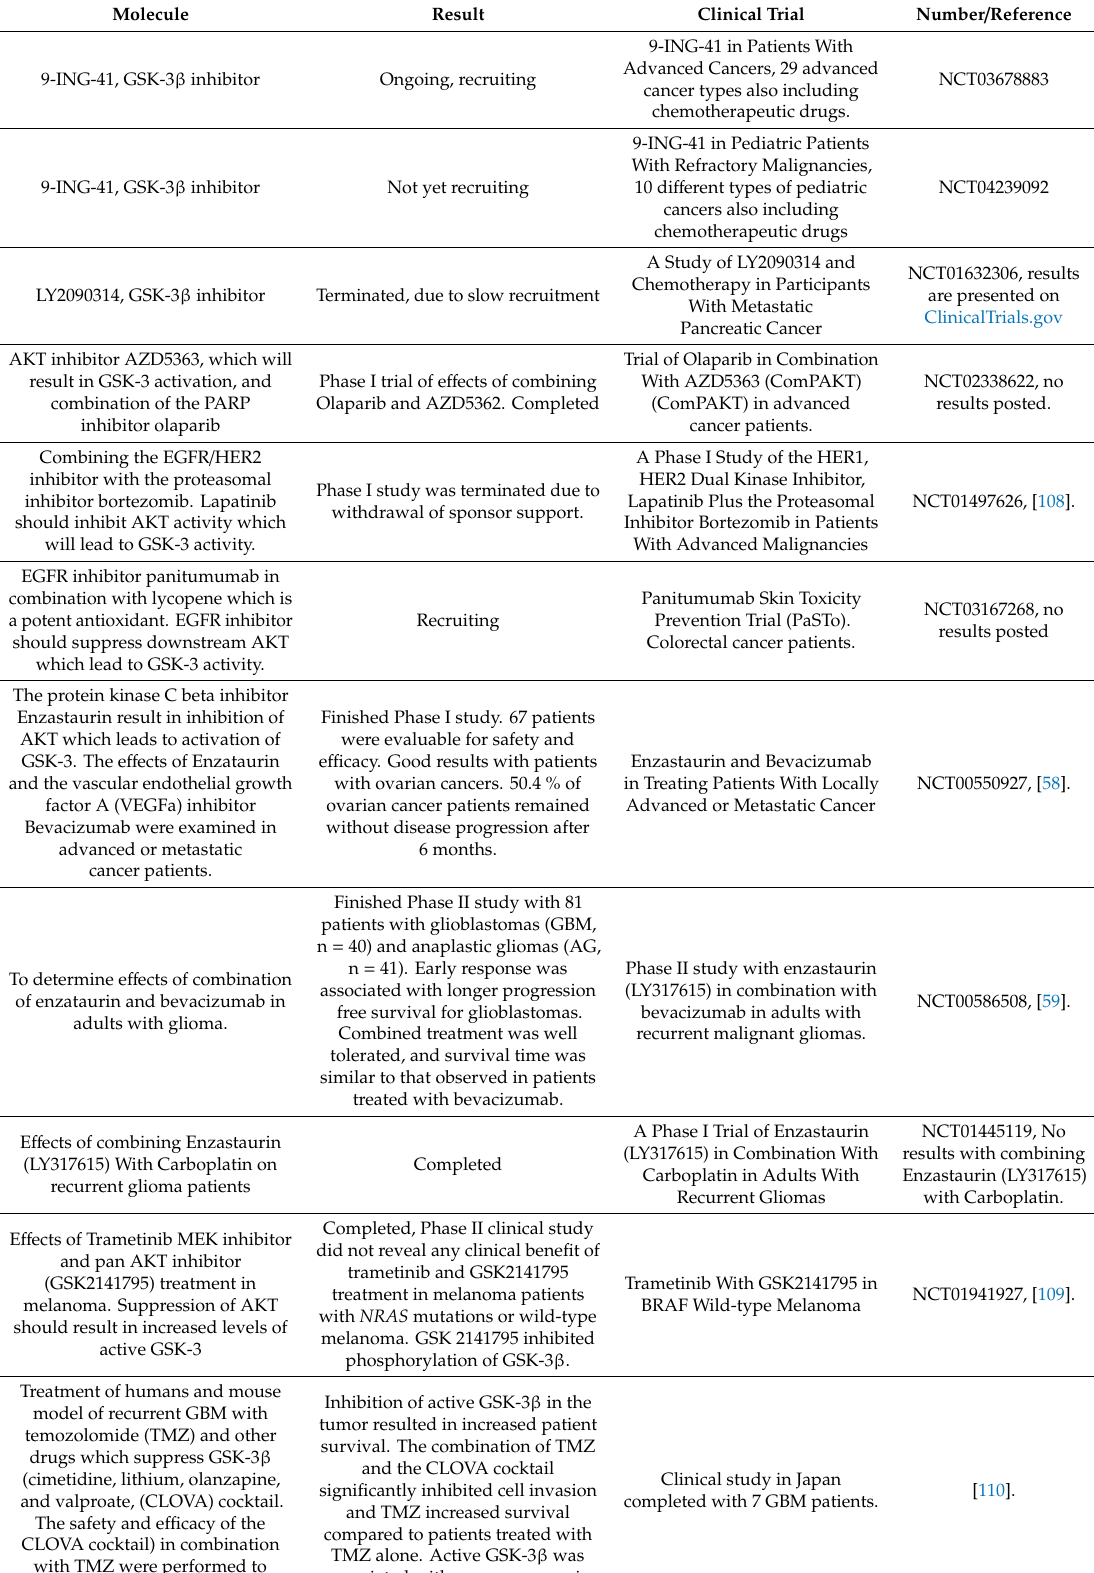
Table 2. Small Molecule Inhibitors Used to Inhibit GSK-3 Activity in Clinical Trials /